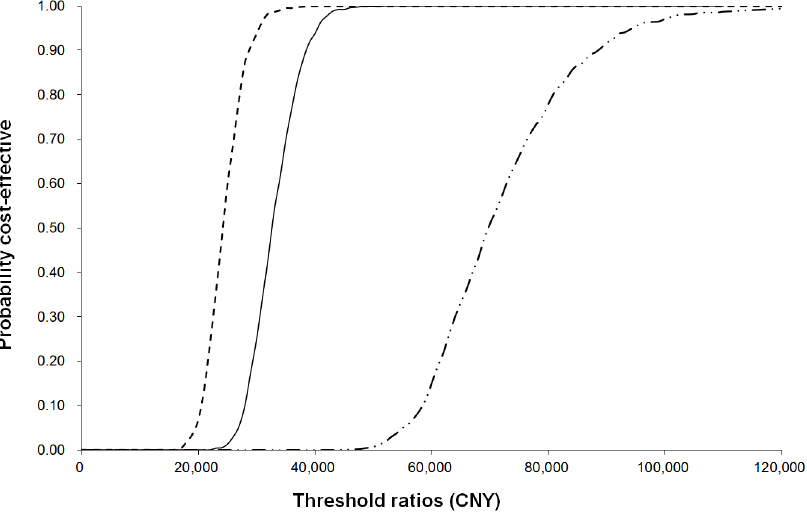
Figure 1. CEACs of life expectancy analysis for RRD surgery in the 70–79-year-olds, the above-80-year-olds, and all the elderly patients. The upper most dashed line represents the CEAC for RRD surgery in the 70–79-year-olds. The solid line represents the CEAC for RRD surgery in all of the elderly people. The dot-dashed line represents the CEAC for RRD surgery in the above-80-year-olds. RRD, Rhegmatogenous retinal detachment; CNY, Chinese yuan; QALY, quality-adjusted life year; CEAC, Cost-effectiveness acceptability curve.